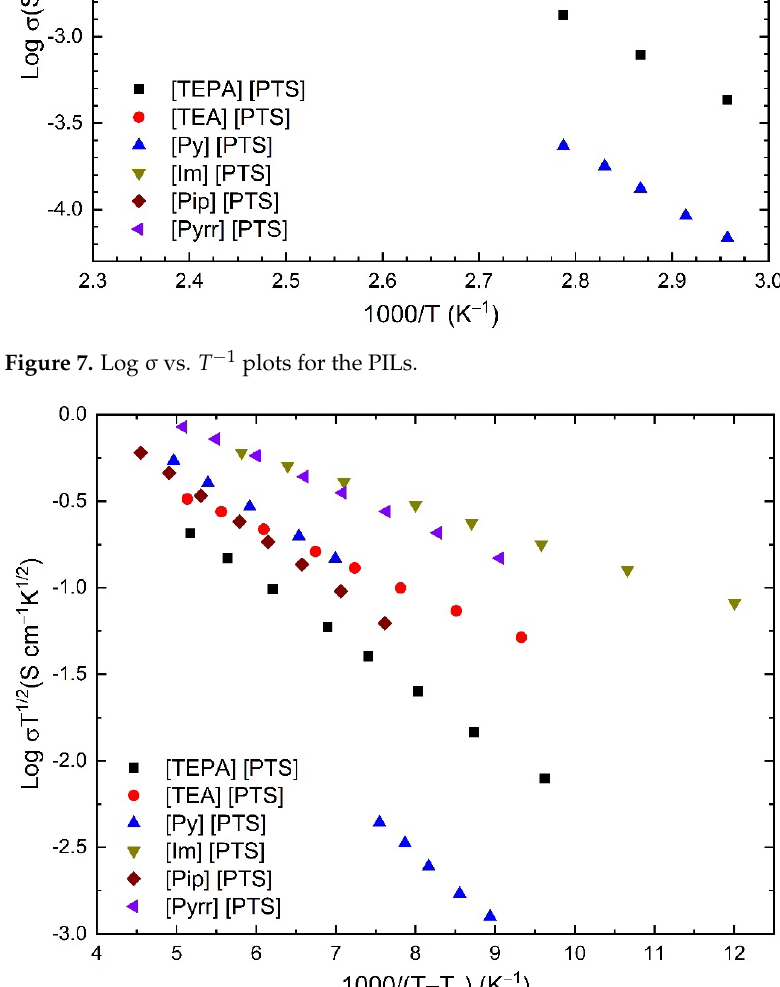
Figure 8. Log σT ½ vs. (T − T o ) − 1 plots for the PILs.